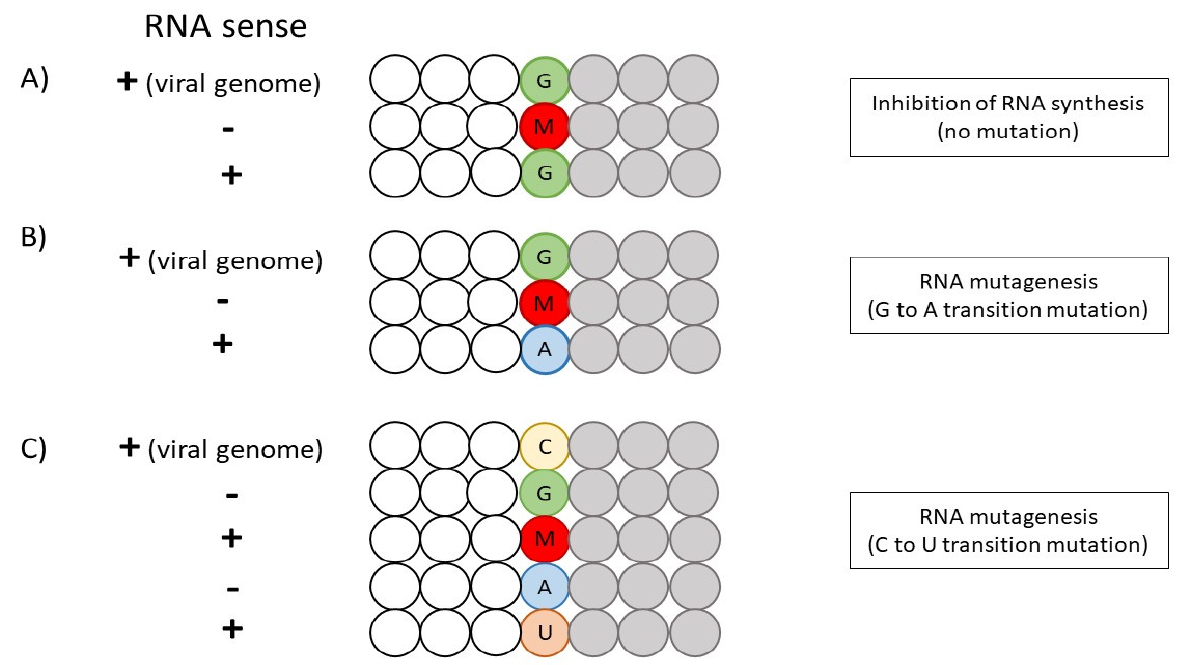
Figure 3. An overview of NHC-induced mutagenesis of SARS-CoV-2 RNA. ( A ) The inhibition of RNA synthesis via [G: NHC-TP: G] base-pairing. ( B ) NHC-induced RNA mutagenesis via G-A transition mutation. ( C ) NHC-induced RNA mutagenesis via C-U transition mutation. The letters G (green), C (yellow), A (blue) and U (orange) represent the ribonucleotide bases, while the letter M (red) refers to Molnupiravir (NHC-TP). The gray circles illustrate the incorporation of NTP after M (NHC-TP).